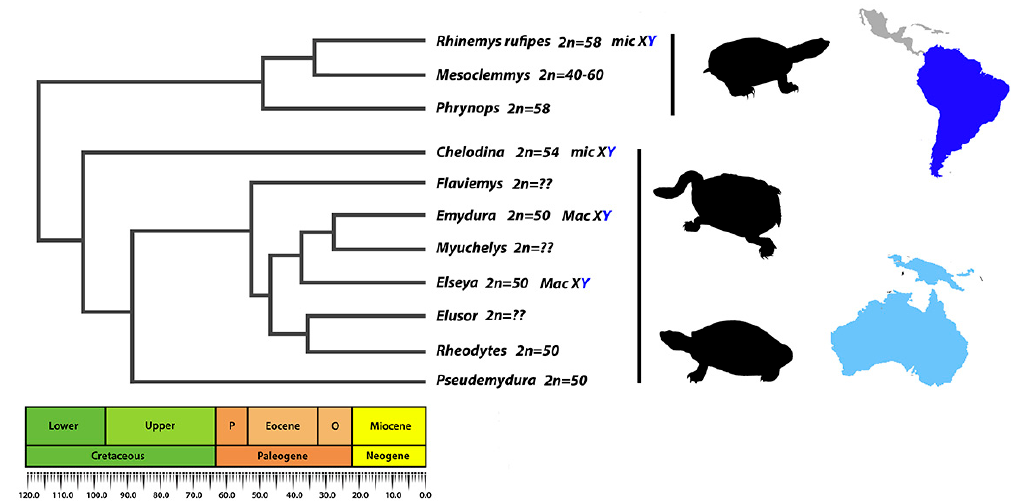
Figure 5. Chronogram for some chelid species, adapted from Pereira et al. [42]. P = Paleocene and O = Oligocene.